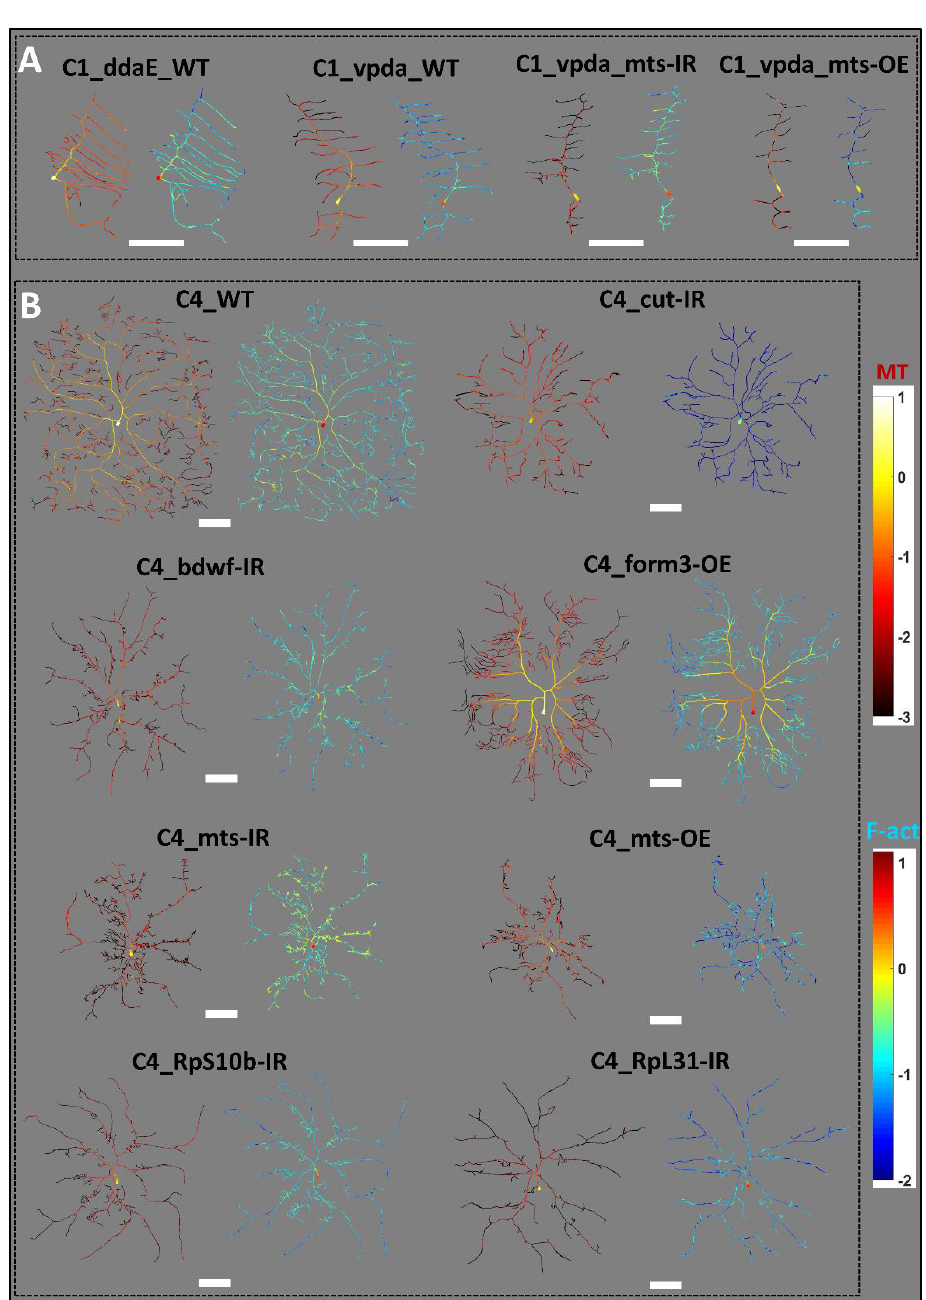
Figure 1. Morphological Diversity of Sensory Neurons in the Drosophila Larva. Single representative neurons from ( A ) 4 Class I neuron types (from left to right: WT ddaE, WT vpda, vpda mts-IR, and vpda mts-OE) and ( B ) 8 Class IV neuron types (from left to right, then top to bottom: WT, cut-IR, bdwf-IR, form3-OE, mts-IR, mts-OE, RpS10b-IR, and RpL31-IR). Each neuron is shown in two separate images side by side, displaying microtubule (left, red hue) and F-actin (right, green-blue hue) distributions, respectively. Color scales on the right side of the figure, constant for all 17 neuron groups, represent the log 10 of microtubule (right-top) and the log 10 of F-actin (right-bottom) quantities, respectively. Scale bars below each single neuron image-pair correspond to 100 µm.